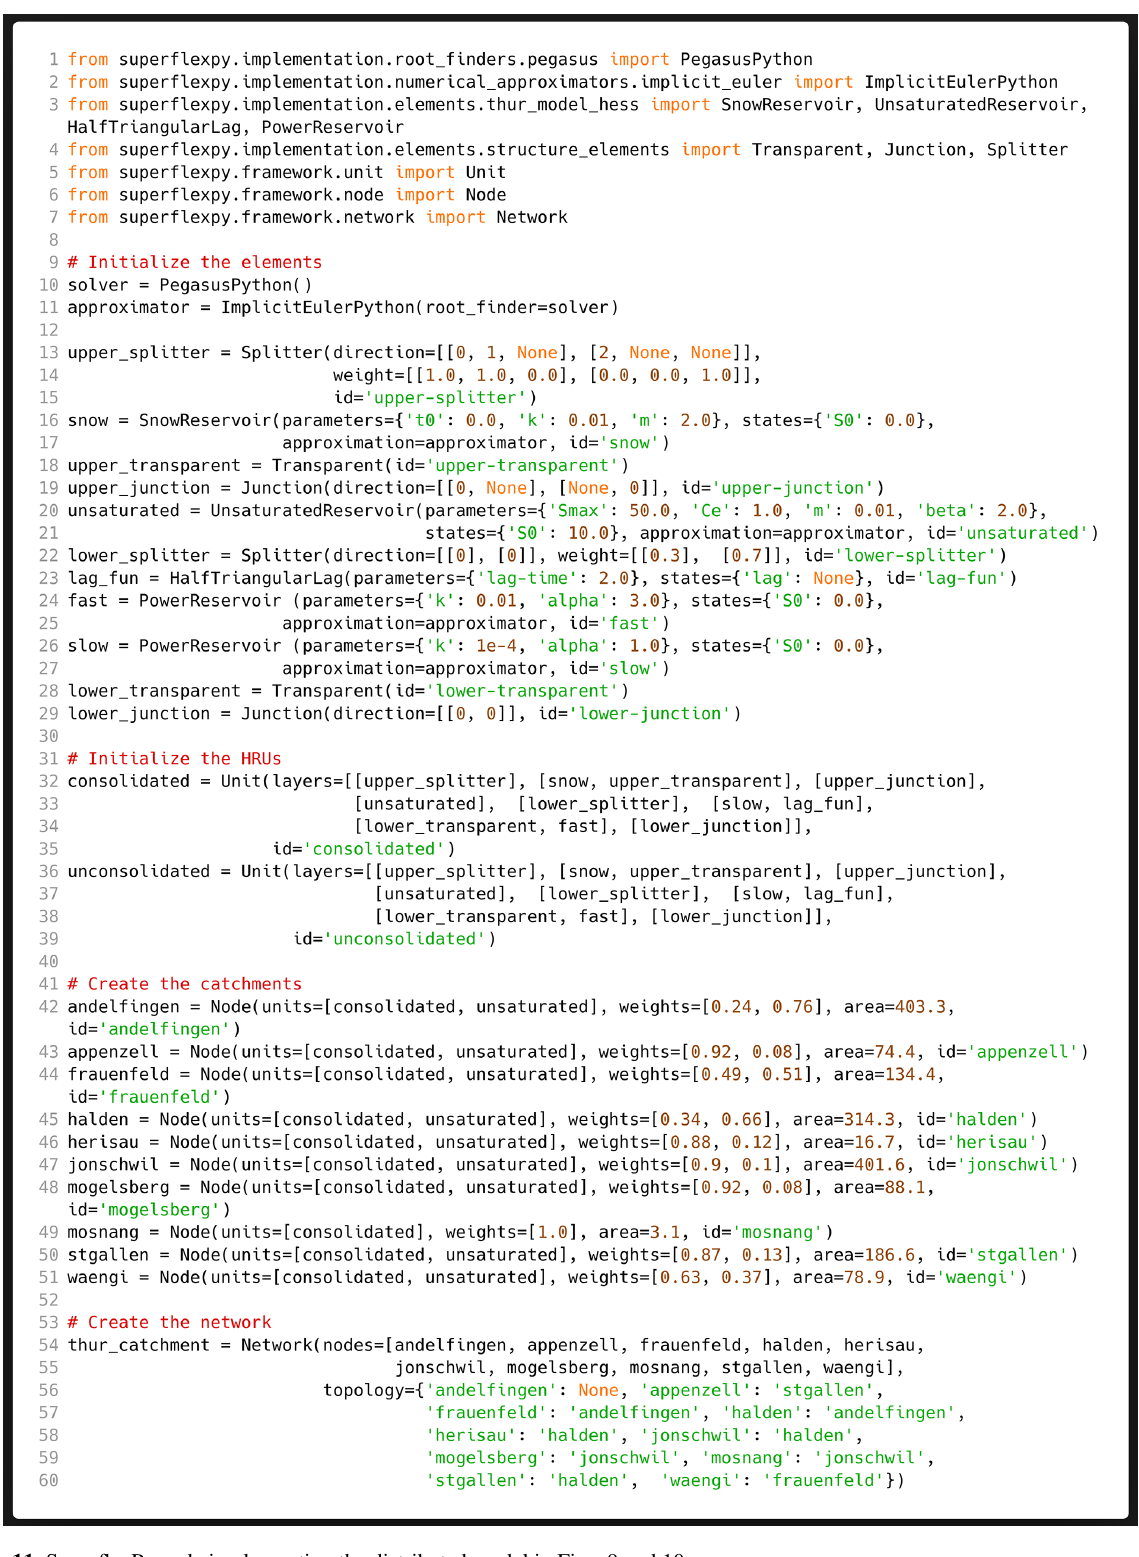
Figure 11. SuperflexPy code implementing the distributed model in Figs. 9 and